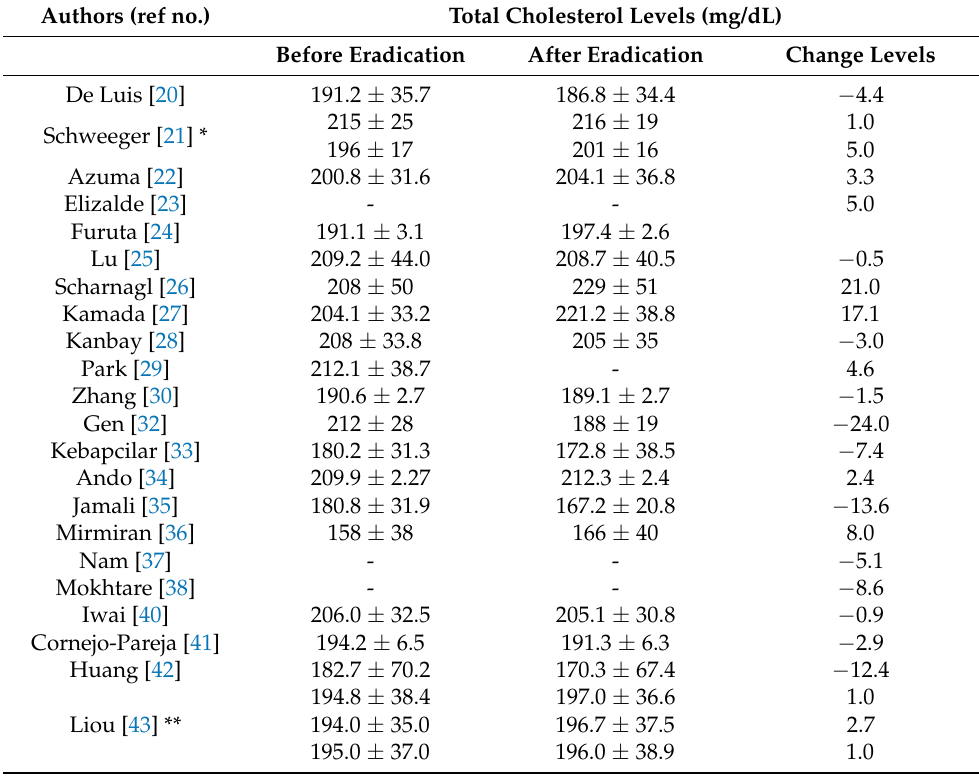
Table A4. Summary of levels of total cholesterol before and after